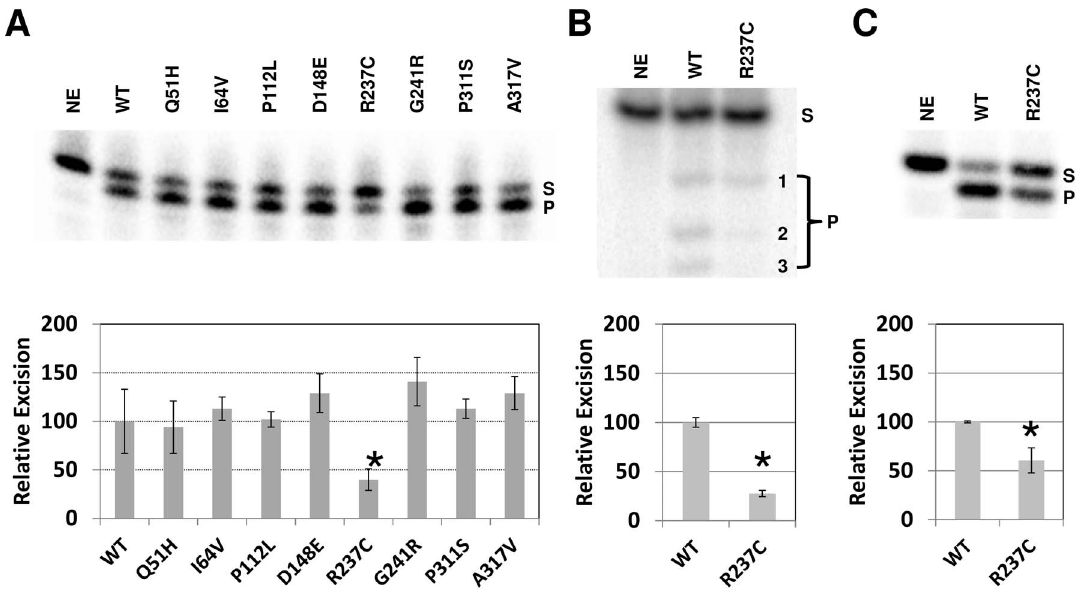
Figure 4. Exonuclease and 3 9 -repair assay. ( A ) Wild-type (WT) and variant APE1 proteins (250 ng) were incubated with 32 P-labeled partially duplex 15P/34G DNA substrate (0.5 pmol), and the reactions were resolved on a high resolution denaturing sequencing gel (top). Substrate (S) and exonuclease degraded product (P) were visualized and quantified using standard phosphorimaging analysis. NE=no enzyme. Graph of relative 3 9 to 5 9 exonuclease efficiency is shown (bottom), depicting the average and standard deviations of 4 independent experiments. *, p=0.01. ( B ) Partial duplex 17P/34G substrate (0.5 pmol) was incubated with APE1 proteins (250 ng) and products were resolved on a high resolution denaturing sequencing gel. Products were detected using phosphorimaging analysis. Densitometry results are graphed below from 3 independent assays. *, p=0.0009. ( C ) The 3 9 -phosphate partial duplex 15-p/34G DNA substrate (0.5 pmol) was incubated with APE1 proteins (1 ng) and products were resolved on a high resolution denaturing sequencing gel. Densitometry results are graphed below from 3 independent assays. *, p=0.01.